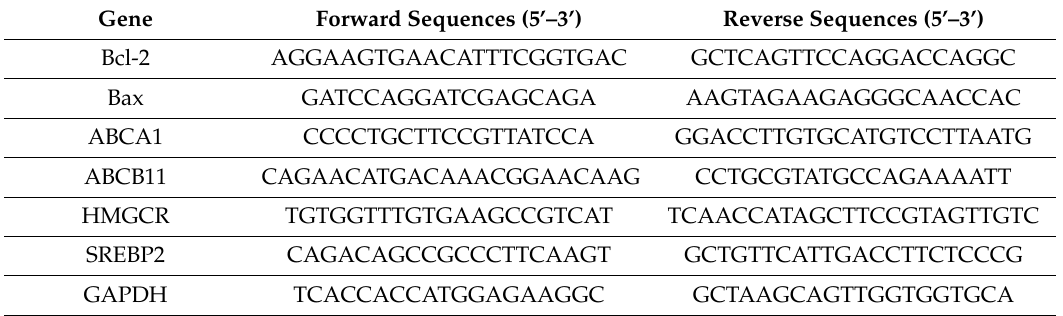
Table 1. Primers used for real-time